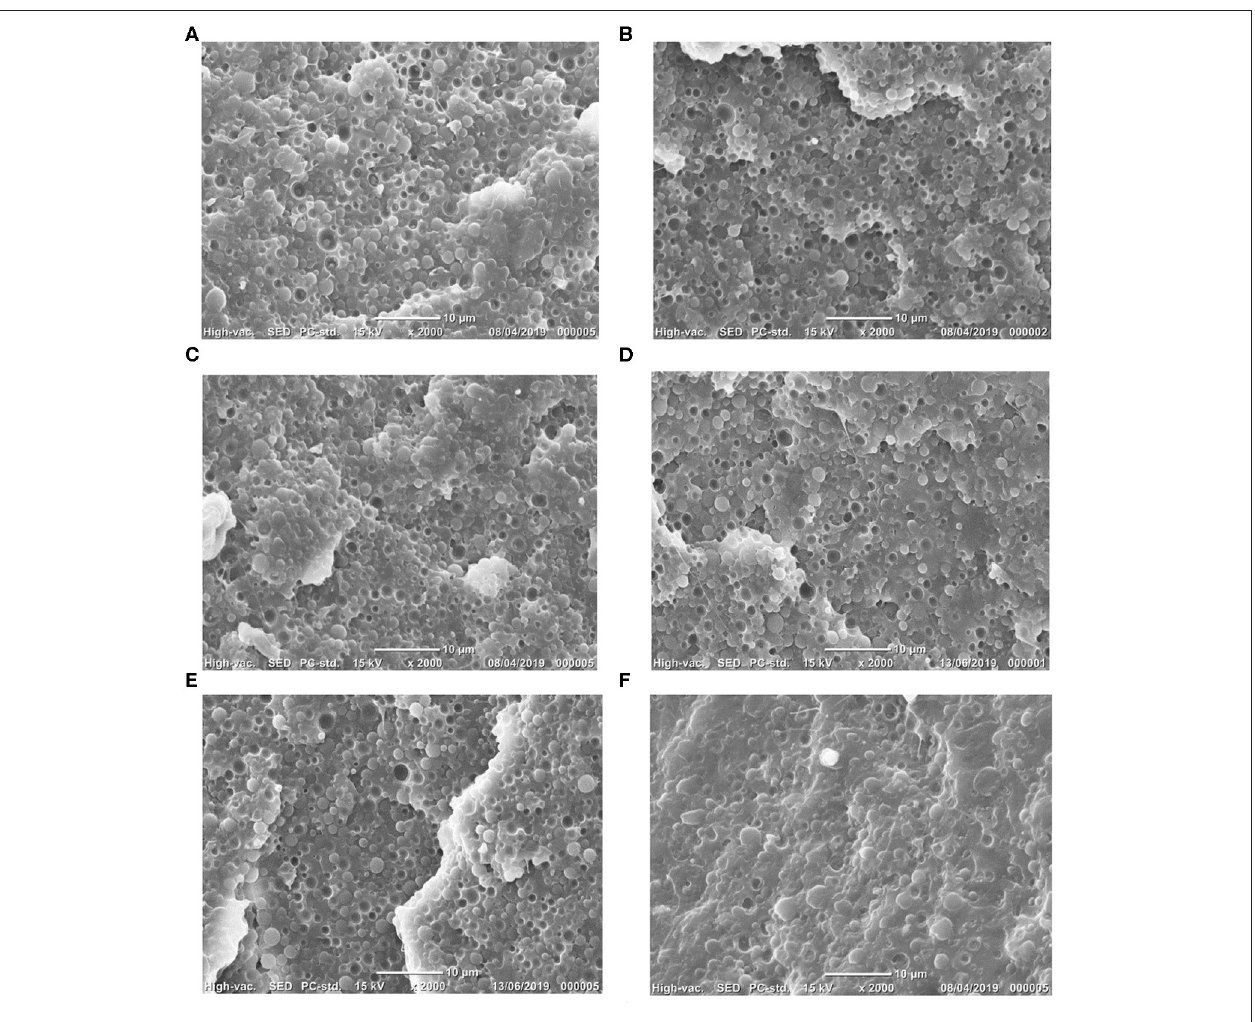
FIGURE 4 | Morphology of PLA/PA/PLA-g-MA of various compositions (A) 70/30/0, (B) 69/30/1, (C) 68/30/2, (D) 67/30/3, (E) 66/30/4, and (F)